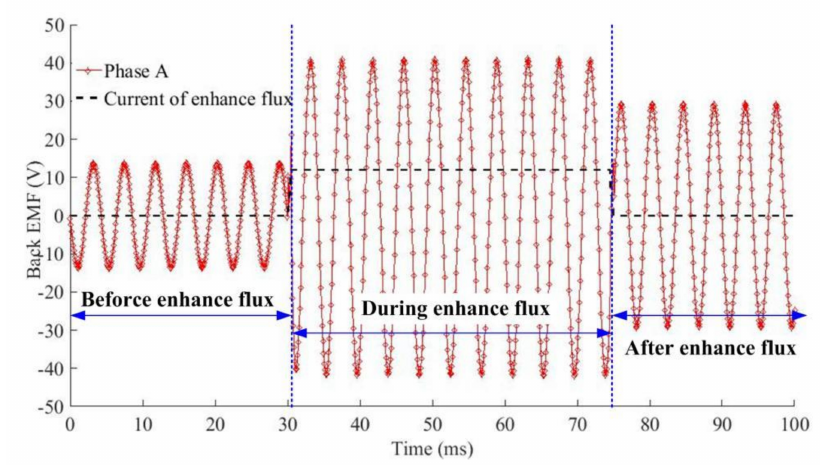
Figure 4. Enhanced flux process of VFMPM machine.